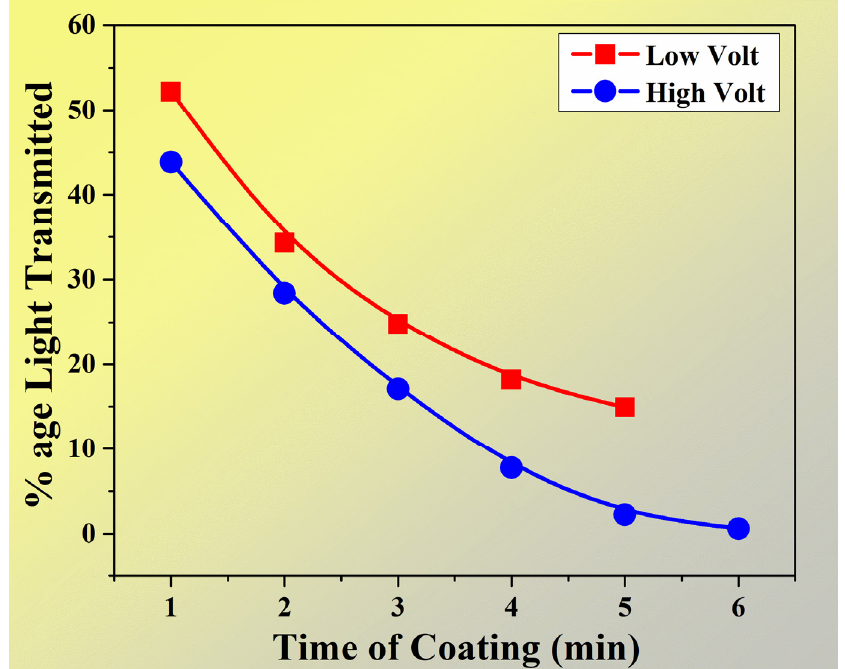
Figure 5. Comparison of Sputtered Coatings at Different Voltages.